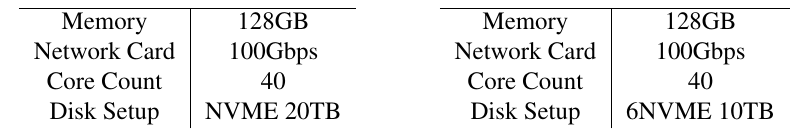
Table 1. Kansas City (left) and UCSD(right) server